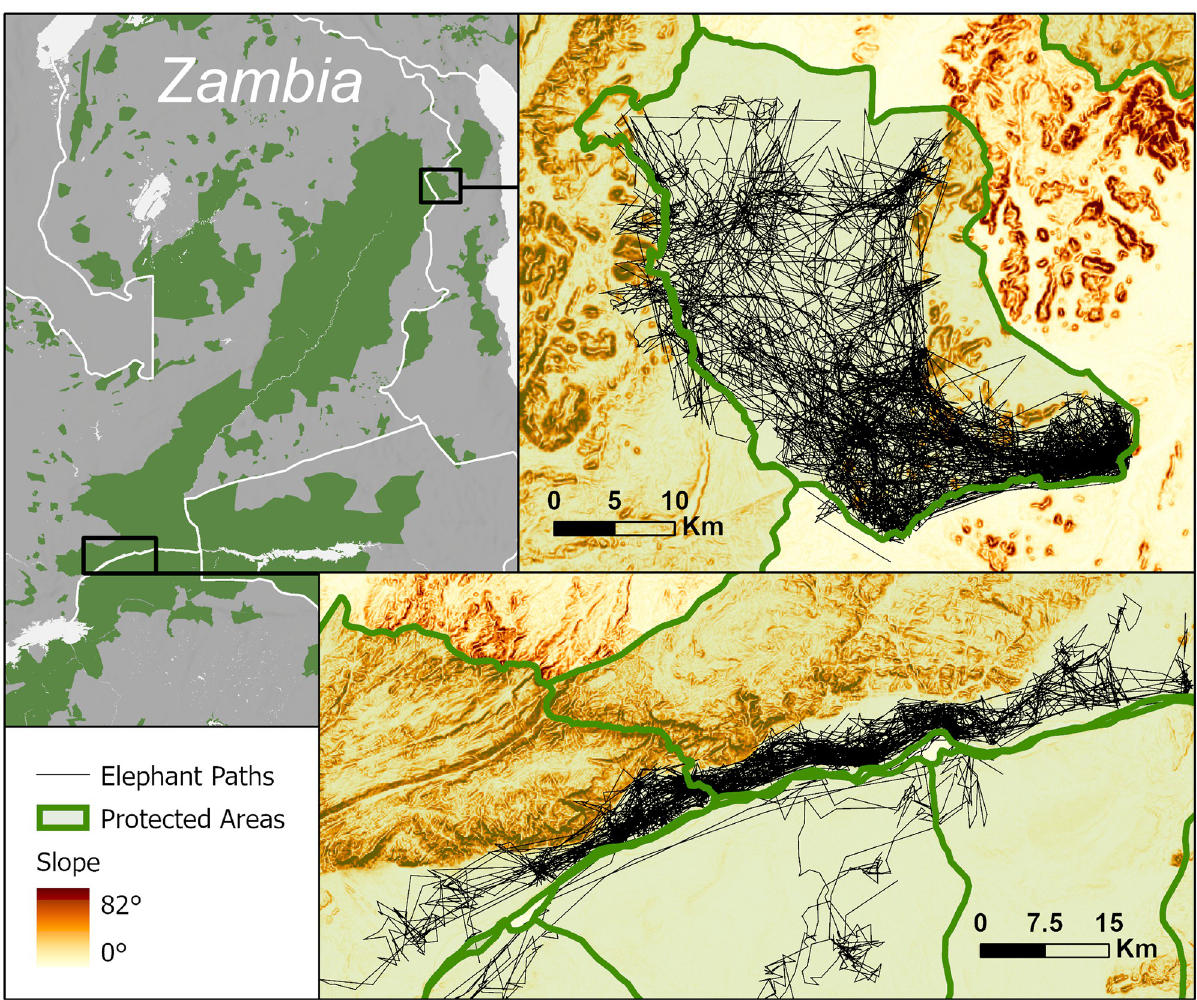
Fig 5. Map of elephant paths in Luangwa and Zambezi. Telemetry paths of elephants (black lines) in part of the Luangwa and Zambezi clusters overlaid on a map of slopes [28]. Green areas in the subset map mark protected areas from the WDPA